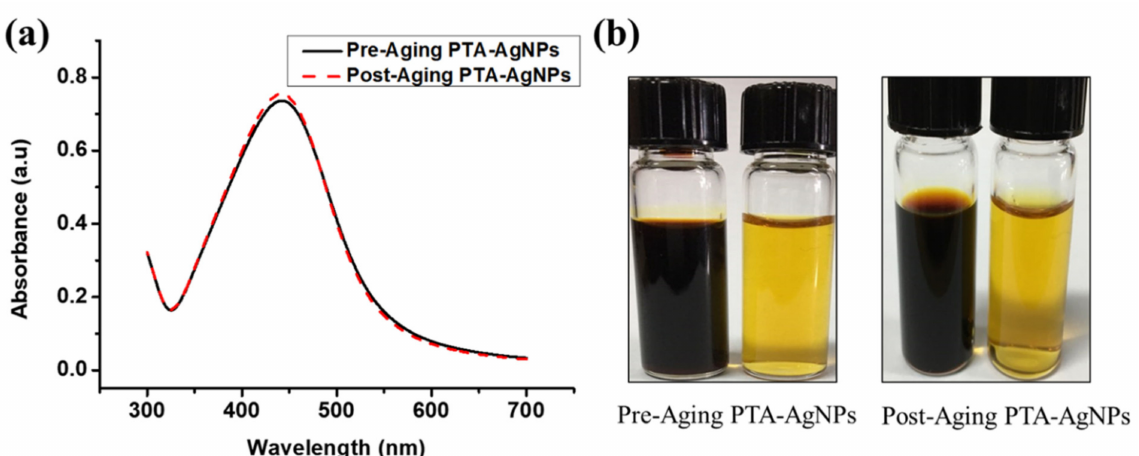
Figure 6. ( a ) UV-Vis spectra of freshly prepared Ag NPs-PTA solution and Ag NPs-PTA solution after 15 months of storage in a dark ambient environment; ( b ) Concentrated and diluted samples of synthesized Ag NPs-PTA before and after aging of 15 months.